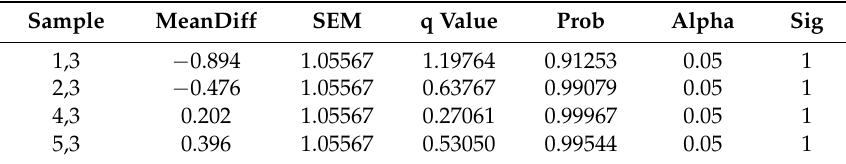
Table 3. Tukey test of the EMCs of the composites along the desorption direction.